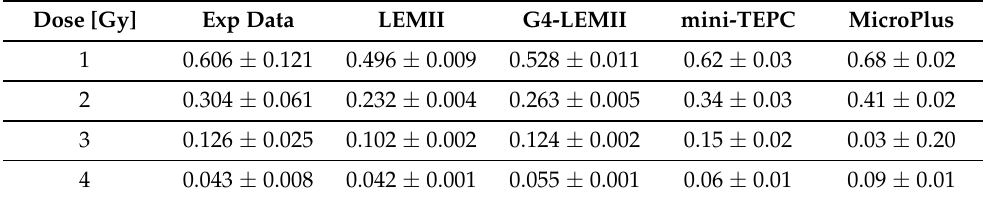
Table 3. Survival Fraction of the 92.1 cell line obtained applying the three approaches: LEMII, Geant4 coupled with LEMII and Loncol’s function applied to the microdosimetric spectra. The first column reports experimental data.